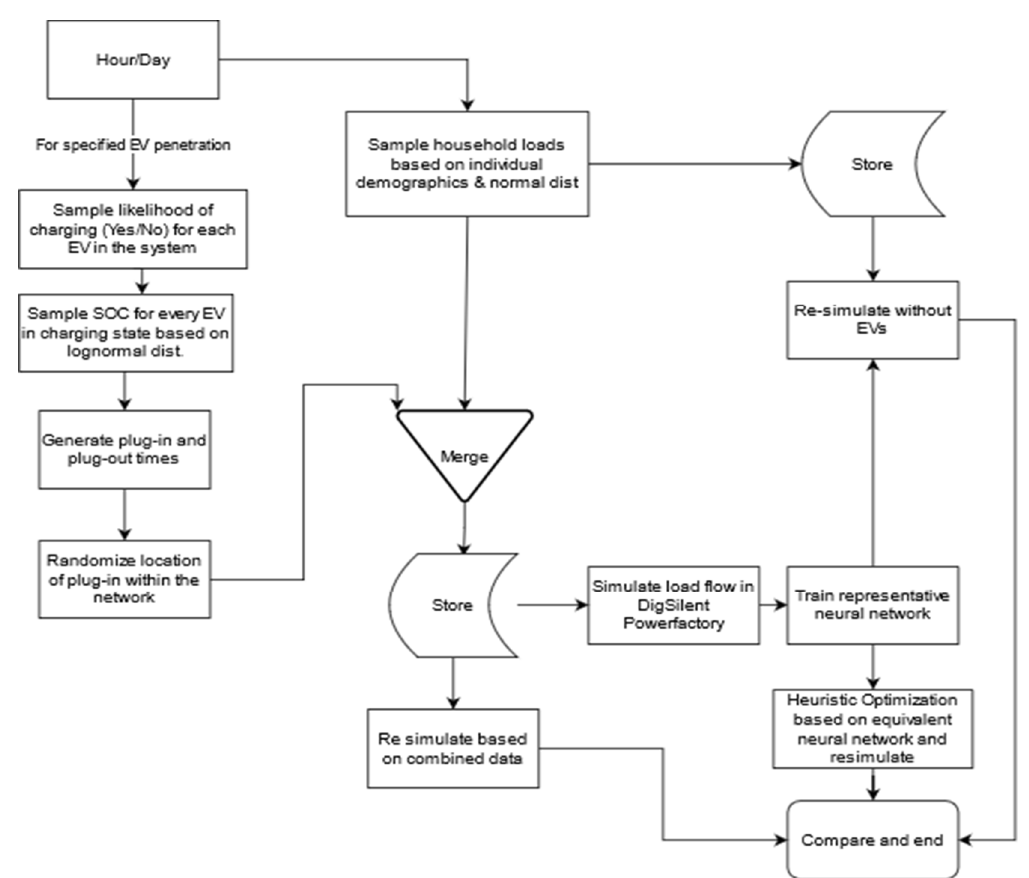
Figure 1. Methodology to generate EV charging models and calculate plug-in and out times based on Monte-Carlo simulation. The methodology is similar to those presented in the literature, and is kept constant across all simulations in this paper [4].